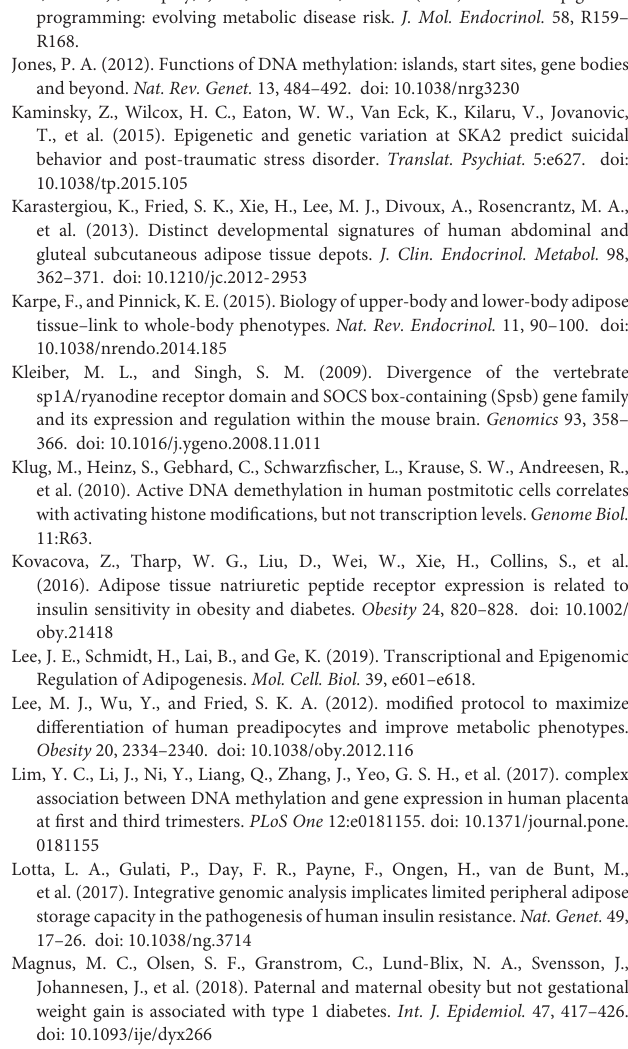
Supplementary Table 1 | List of differentially methylated sites between 10 Apple and 7 Pear-shaped women in A-FAT, GF-FAT, A-preadipocytes and GF-preadipocytes. Anova, p -value < 0.05, (Apple β -value)-(Pear β -value) ≥ 0.2. Supplementary Table 2 | List of differentially expressed genes between Apple and Pear-shaped subjects in abdominal and gluteofemoral scWAT. Deseq2, p -value < 0.05. Supplementary Table 3 | List of differentially methylated sites between A and GF in 10 apple-FAT, 7 pear-FAT, 10 apple preadipocytes and 7 pear